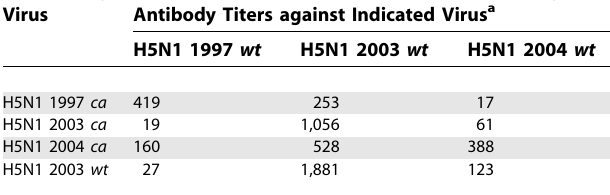
Table 6. Serum Neutralizing Antibodies Elicited in Mice Following Two Doses of H5N1 ca Vaccine Immunizing Reciprocal Geometric Mean Serum Neutralizing Virus Antibody Titers against Indicated Virus a